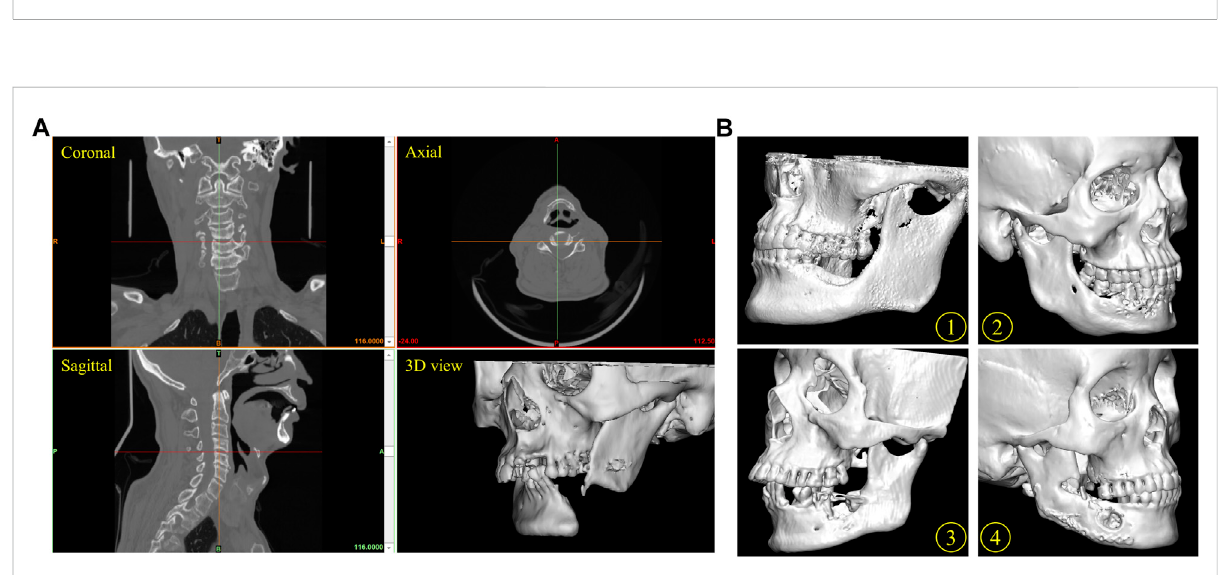
FIGURE 3 Reconstruction of mandible defect based on CBCT image. (A) The process for the generation of a three-dimensional (3D) mandibular reconstruction. Coronal view, axial view, sagittal view and 3D model of mandibular. (B) Several mandibular defects data were used in this study. Patients 1, 2, 3 and